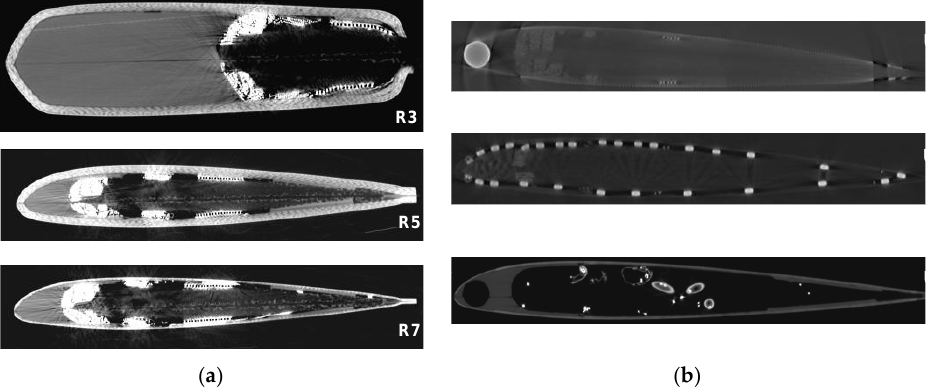
Figure 4. CT scan images at designated radial stations of the blade (not to scale). ( a ) Blade root region and ( b ) blade airfoil region. Higher resolution images can be found in the Supplementary Materials, Figures S2–S7.